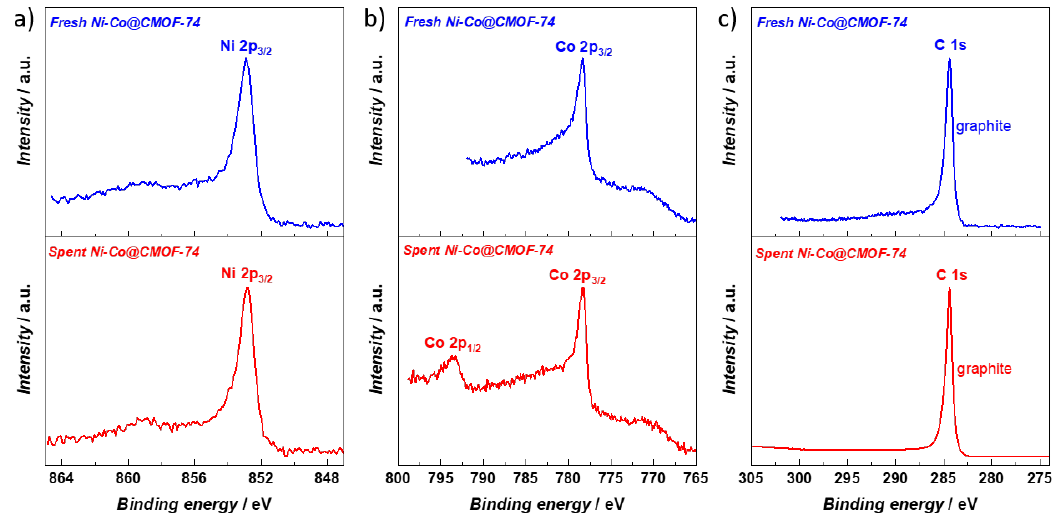
Figure 3. X-ray photoelectron spectroscopy of the Ni-Co@CMOF-74 solid before and after reaction with core levels: ( a ) Ni(2p), ( b ) Co(2p) and ( c ) C(1s).